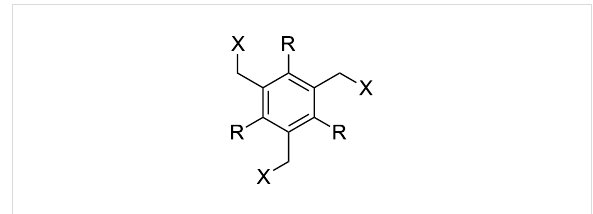
Figure 3: Generalized structural fragments used for mining the Cambridge Structure Database. R = Me and Et, X = N, O, C, Br.